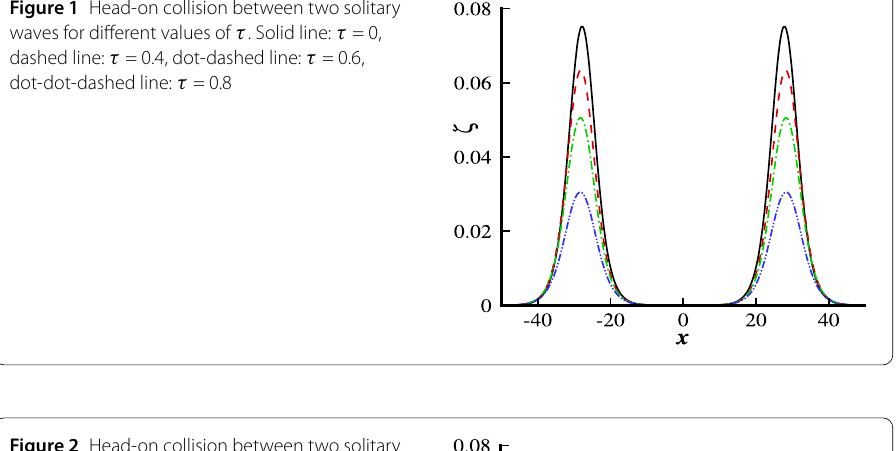
Figure 2 Head-on collision between two solitary waves for different values of d . Solid line: d = 0, dashed line: d = –1/3, dot-dashed line: d = –3/5, dot-dot-dashed line: d = –4/5